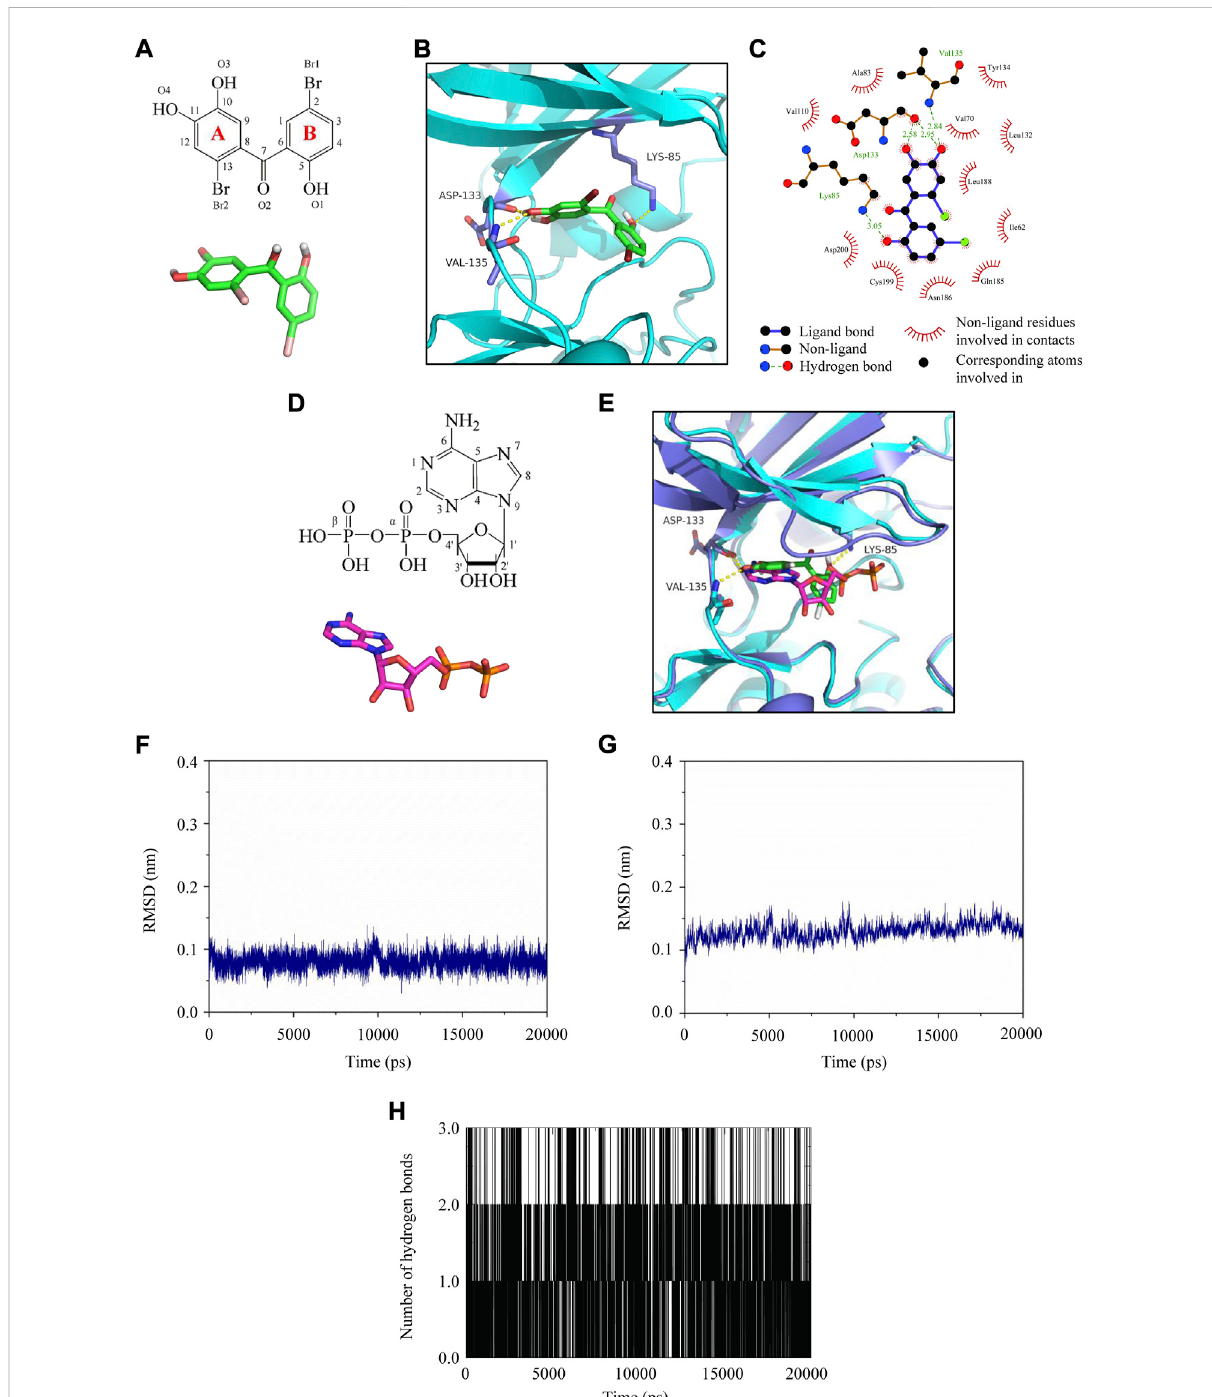
FIGURE 7 Molecular docking and molecular dynamics simulation analysis of LM49 and GSK3 β . (A) Chemical structure and interactive chemical structure of LM49. (B) Binding mode of LM49 and GSK3 β analysed with Autodock4.2. Hydrogen bonds are indicated by the yellow dashed lines. (C) Binding modeofLM49andGSK3 β analysedwithLigPlot. (D) ChemicalstructureandinteractivechemicalstructureofADP. (E) SuperposedGSK3 β structurein complex with LM49 (green backbone) and ADP (magentas backbone). Hydrogen bonds are indicated by the yellow dashed lines. (F) RMSD of LM49 obtained during the 20 ns MD simulation. (G) RMSD of GSK3 β backbone obtained during the 20 ns MD simulation. (H) Hydrogen bond map of LM49 and GSK3 β during the 20 ns molecular dynamics